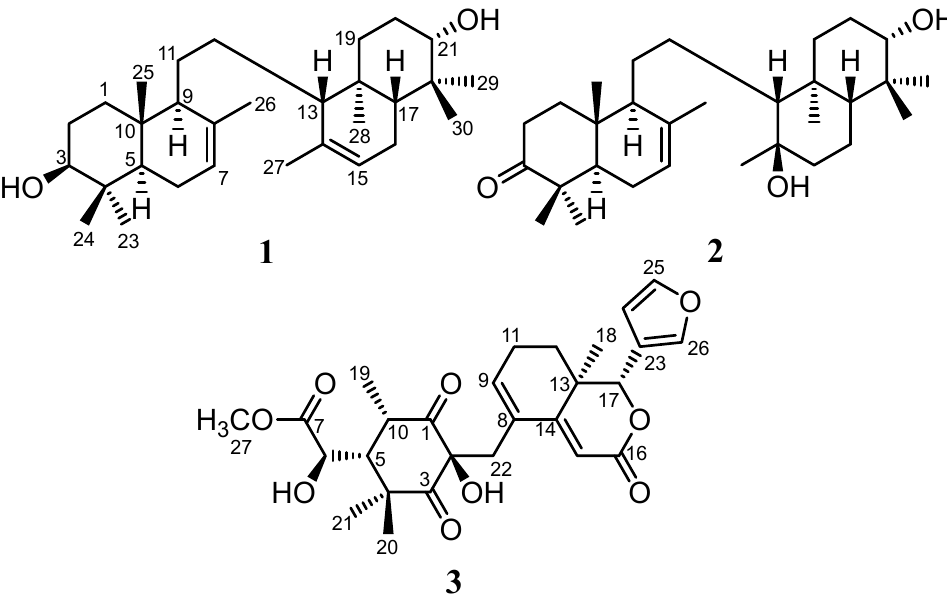
Figure 1. The chemical structures of compounds 1–3 .